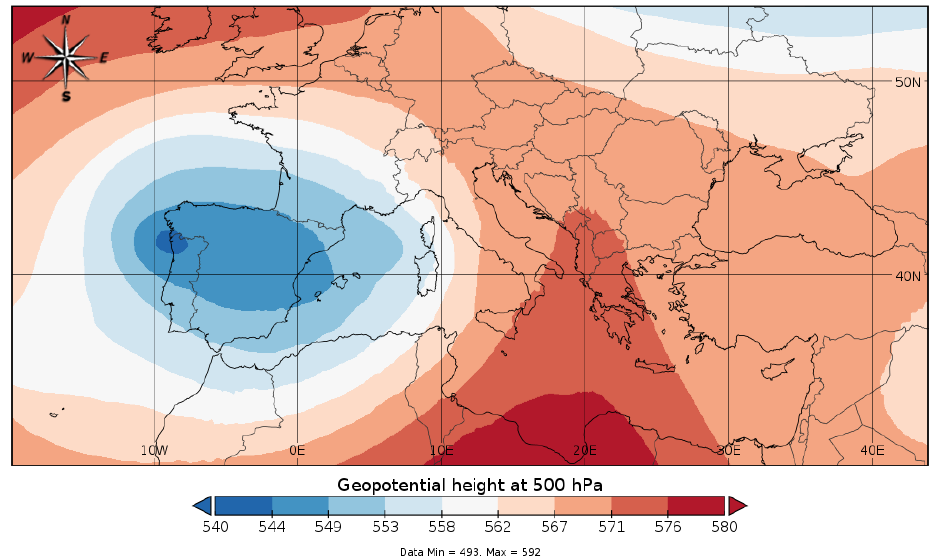
Figure 2. Geopotential at 500 hPa. The synoptic analysis shows a depression vortex located on the Iberian Peninsula.